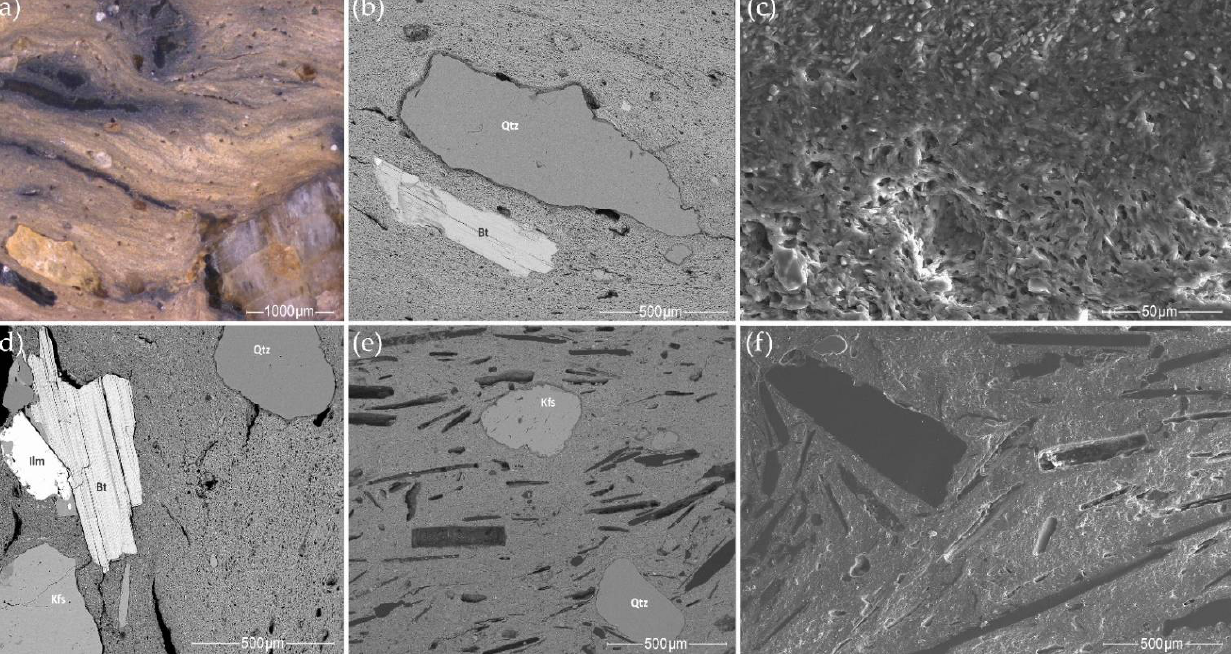
Figure 21. Late coarse pottery: ( a ) HG-L_B3, stereomicrograph of the plastic fine clay matrix with coarse mineral inclusions; ( b ) HG-L_B3, SEM BSE image of the same ceramic paste; ( c ) HG-L_B3, 1000× magnification SEM SE image of the same ceramic paste with a visible boundary between the dark clay matrix (the top of the image) and the light-colored sponge-textured clay; ( d ) HG-L_B4, SEM BSE image; ( e ) HG-L_B2, SEM BSE image; and ( f ) SEM SE image of the clay matrix with straw voids and the few grains of fine to medium sand-sized K-feldspar and quartz.